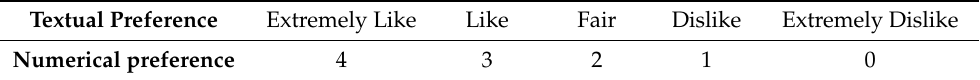
Table 2. Conversion rules between textual and numerical